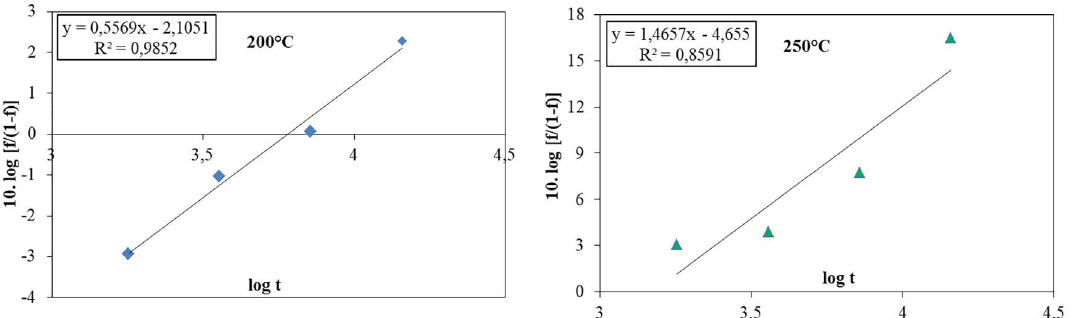
Figure 11. Austin-Riccket’s data fitting of isothermal heat treatments at 200°C and